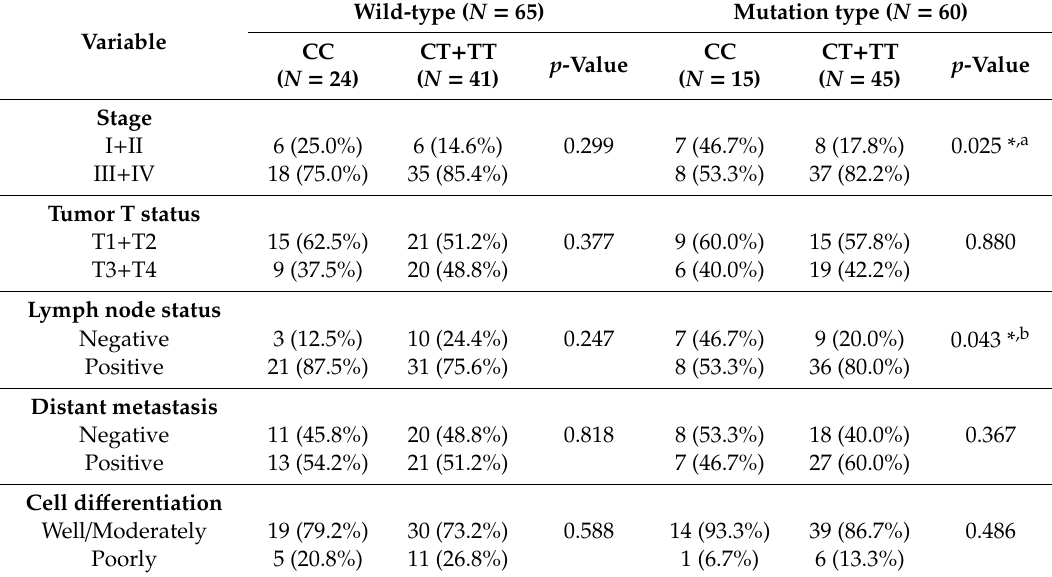
Table 6. Clinicopathologic characteristics of male lung adenocarcinoma patients with the epidermal growth factor receptor (EGFR) mutation, stratified by polymorphic genotypes of tissue inhibitor of metalloproteinases (TIMP)-3